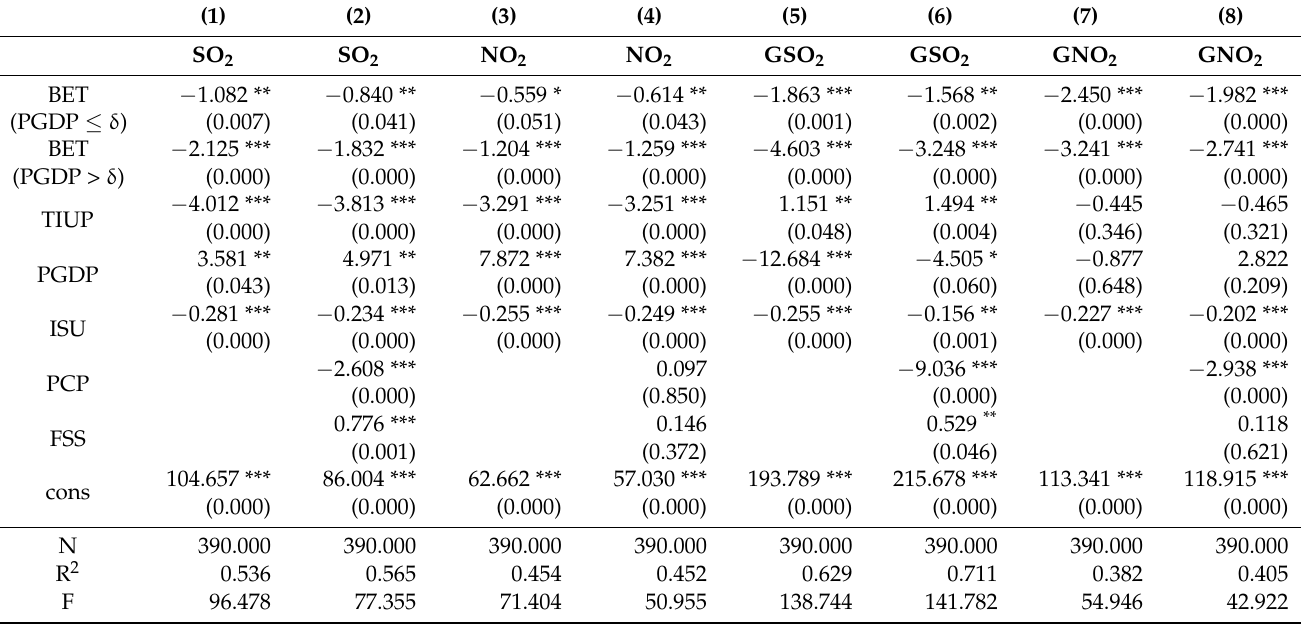
Table 4. Threshold regression